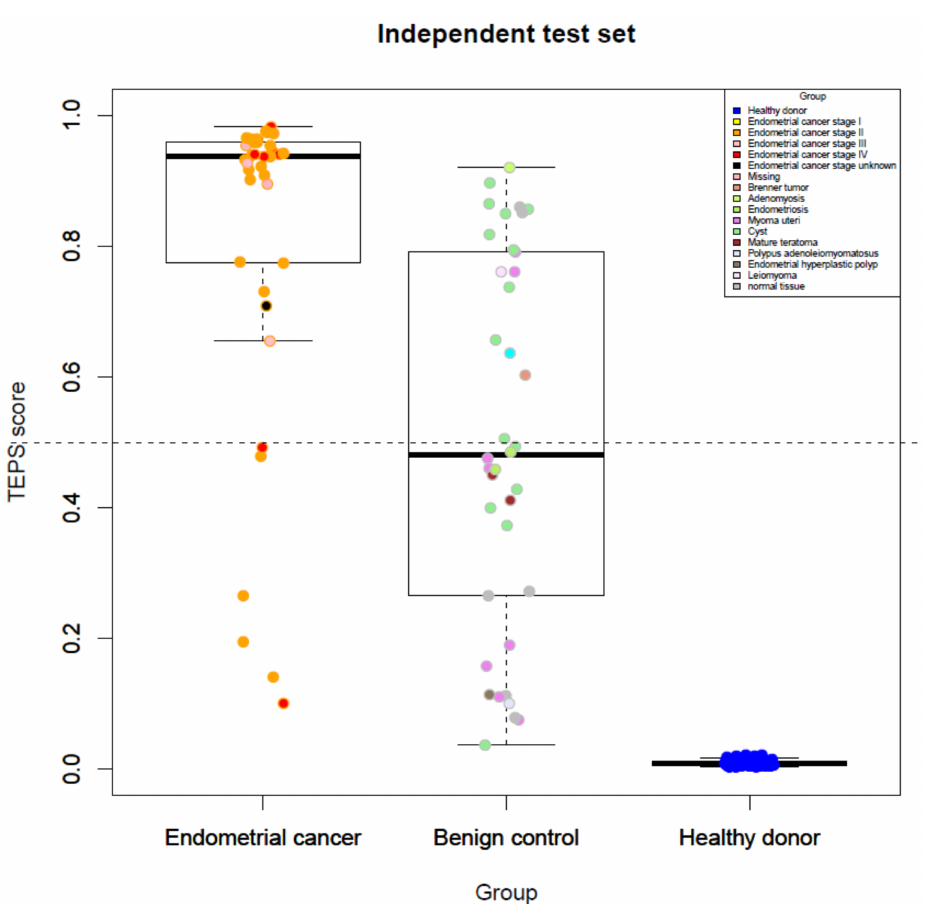
Figure 4. Probability scores for TEPs sequencing results in the test